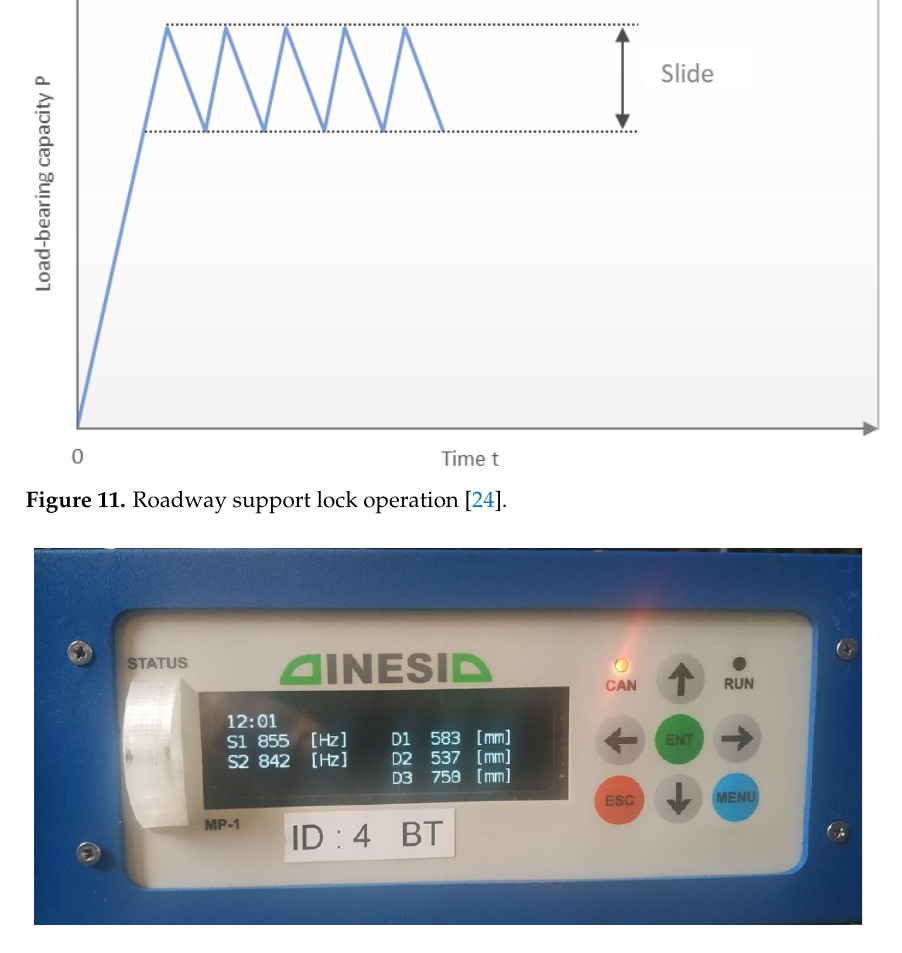
Figure 11. Roadway support lock operation [24].